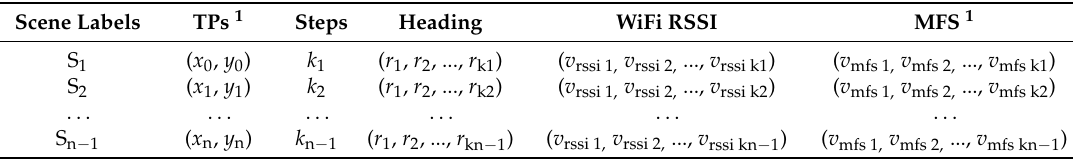
Table 1. Information of data storage.